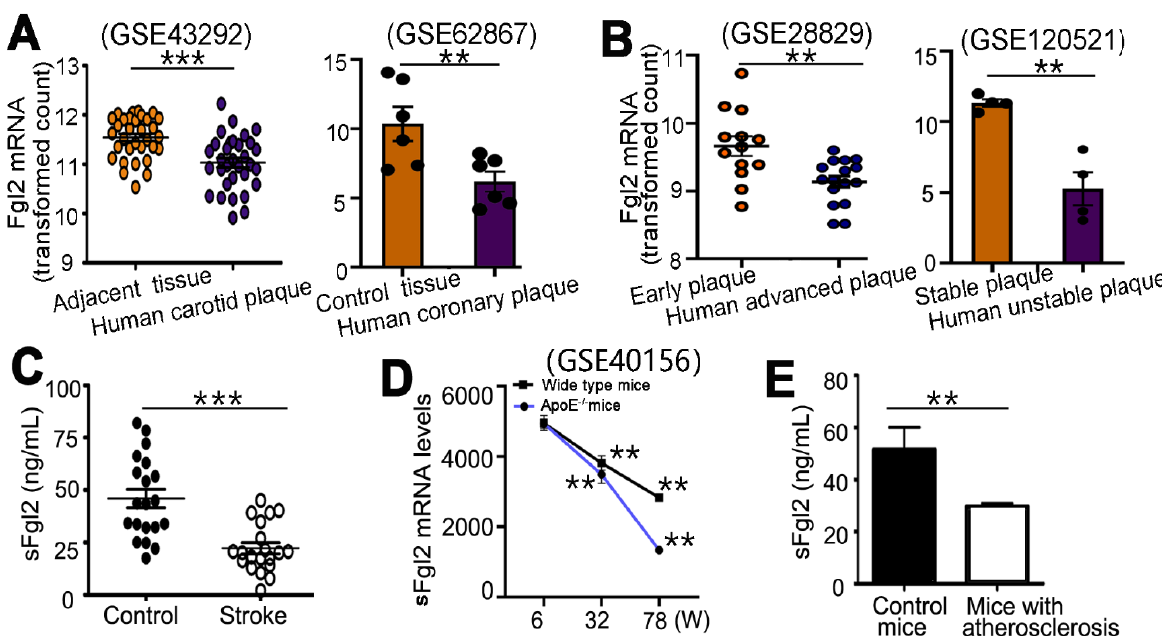
Figure 1. sFgl2 decreased in both human and mouse atherosclerotic diseases. ( A ) Quantification of sFgl2 mRNA relative expression between human carotid plaques and adjacent carotid tissues from microarray data (GSE43292) and between human coronary plaques and control tissues (GSE62867). ( B ) Quantification of sFgl2 mRNA relative expression between advanced human plaques and early plaques (GSE28829) and between human unstable plaques and stable plaques (GSE120521). ( C ) Elisa assay detected changes of sFgl2 protein levels in the plasma of healthy controls (N = 20) and acute stroke patients (N = 20). ( D ) In the aorta of wide-type or ApoE -/- mice fed a Western diet, sFgl2 gradually decreased with time. ( E ) sFgl2 decreased in atherosclerotic mice compared with controls. ** p < 0.01, *** p < 0.001. Data were represented as mean ± SEM.